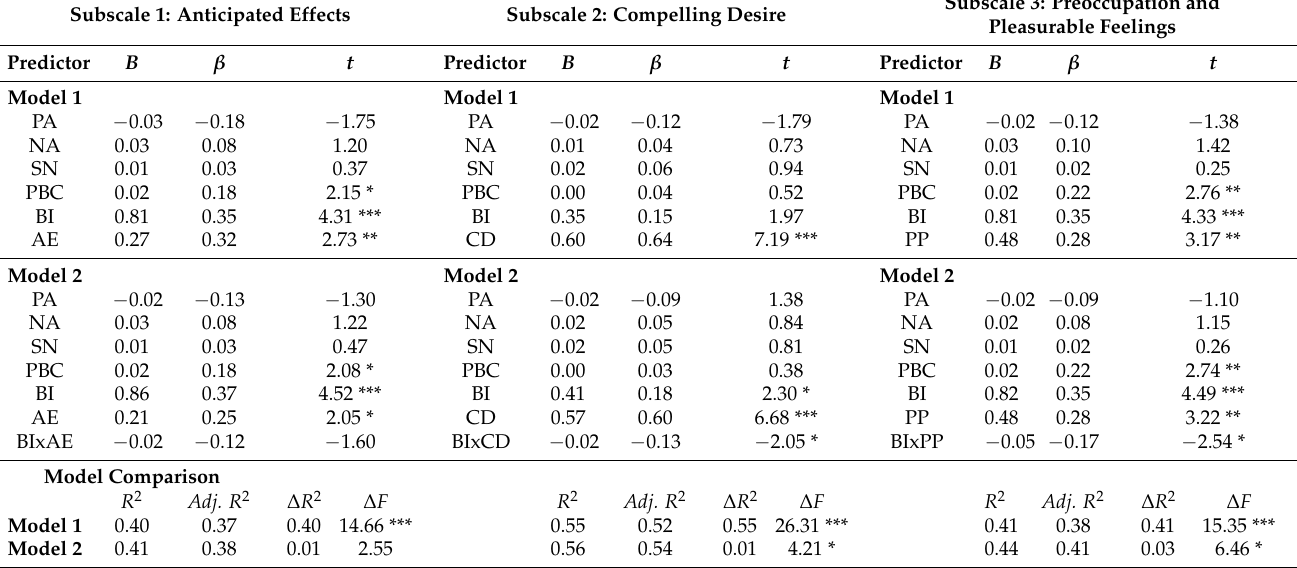
Table 3. The moderation effects of the subscales of the Hypnotic-use Urge Scale on the association between behavioral intention and frequency of hypnotic